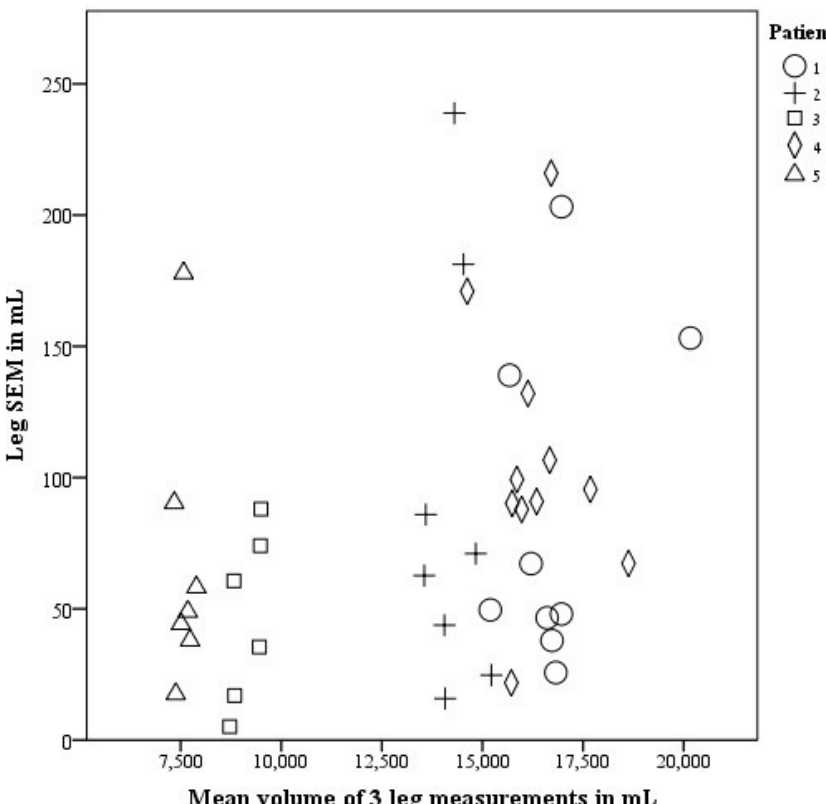
Figure 3. SEM in mL for 41 PTs measuring a leg, each symbol represents a patient.